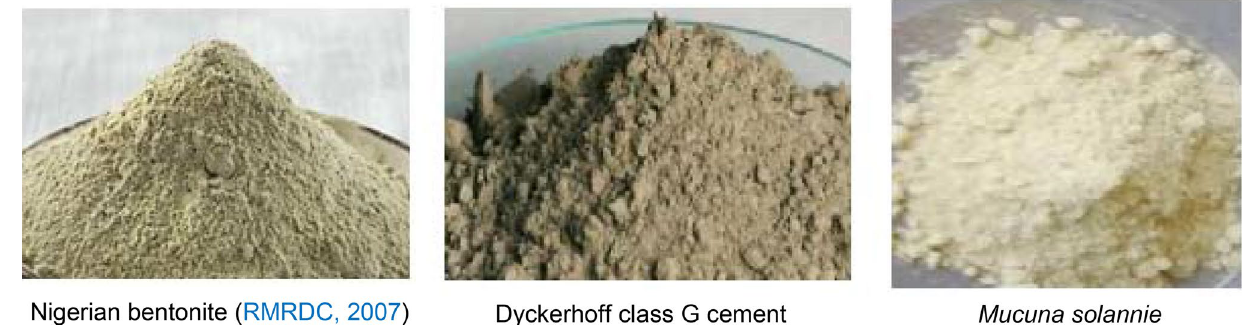
Fig. 2 Samples of Bentonite, Dyckerhoff class G cement, and Mucuna solannie